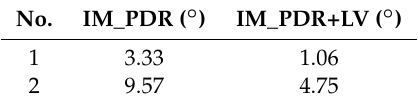
Figure 10. Results of L-shape test: ( a ) comparative trajectories; ( b ) comparative heading errors.